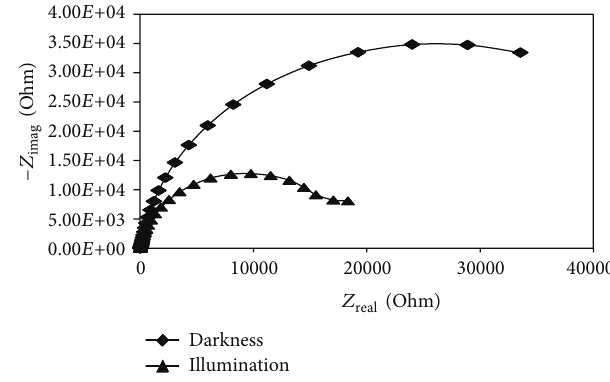
Figure 7: Nyquist curves of ITO/EB-MWCNT/ZnO-rhodamine B/ITO structure in darkness and